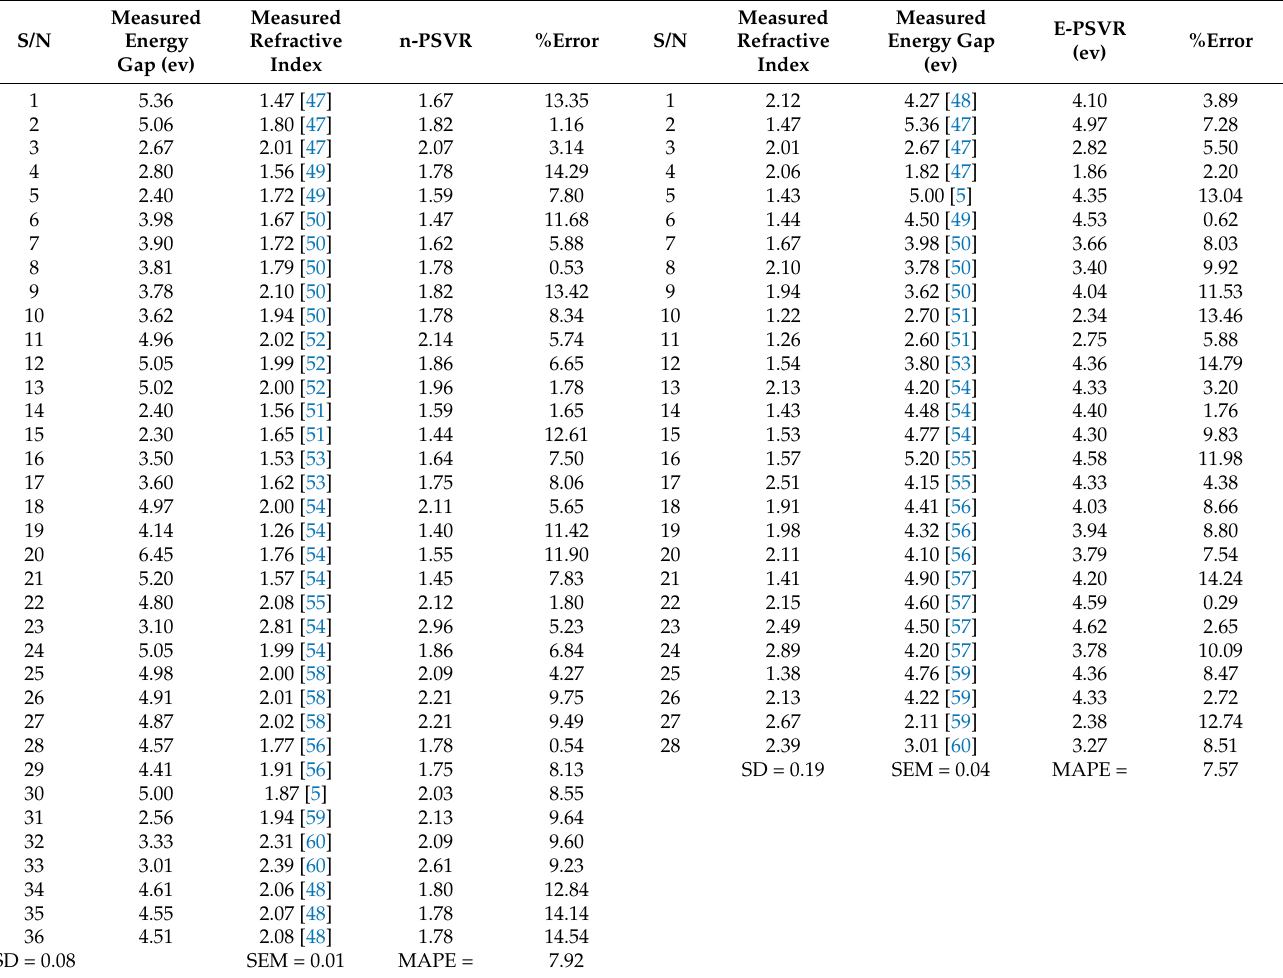
Table 3. Results of external validation of the developed hybrid